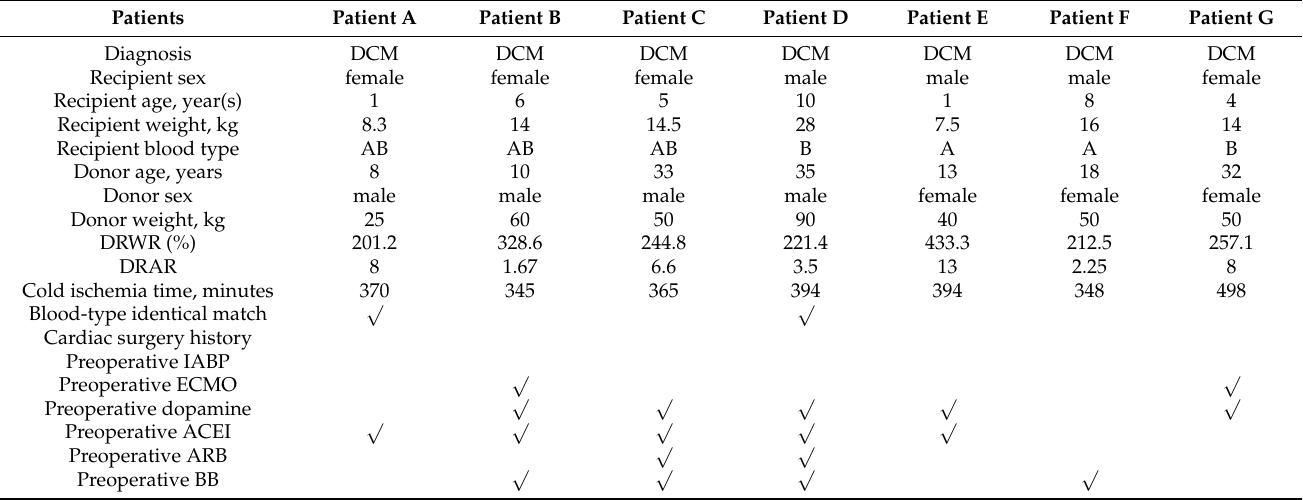
Table 4. Detailed baseline characteristics of patients with a DRWR > 200%.